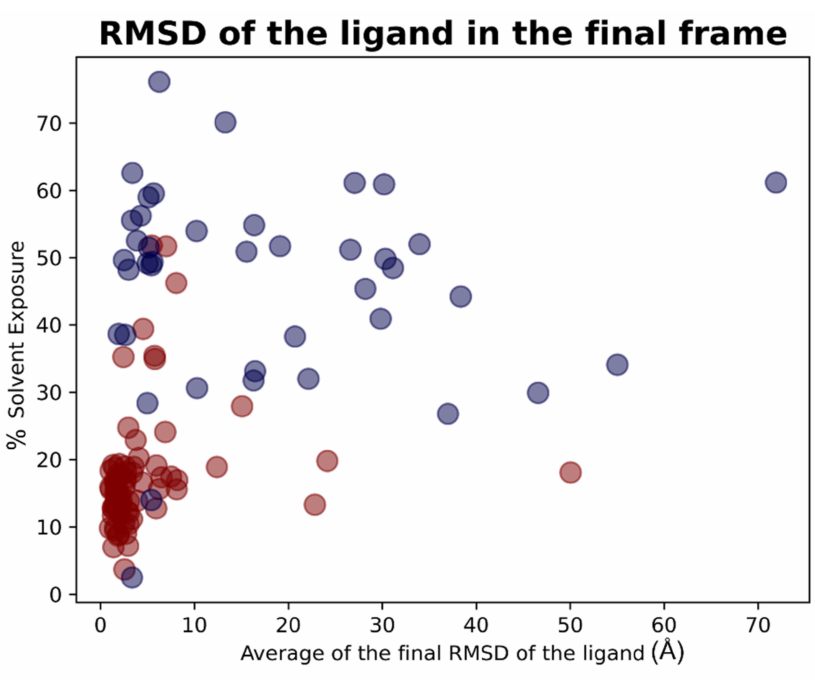
Figure 14. Scatter plots showing the different distribution of the mean RMSD values between the final coordinates of the M pro ligands compared to crystallographic ones after the molecular dynamics simulations in respect to the solvent exposure of the corresponding crystallographic ligands. The red dots represent the ligands thatwere originally crystallized inside the catalytic pocket, while the blue dots represent the ligands crystallized in the other parts of M pro . As can be noticed, the molecules showing the best values of RMSF after the analysis of the trajectories are mainly located inside the catalytic pocket and characterized by a low solvent exposure of the original crystallographic pose. Table 3. Results of the molecular dynamics